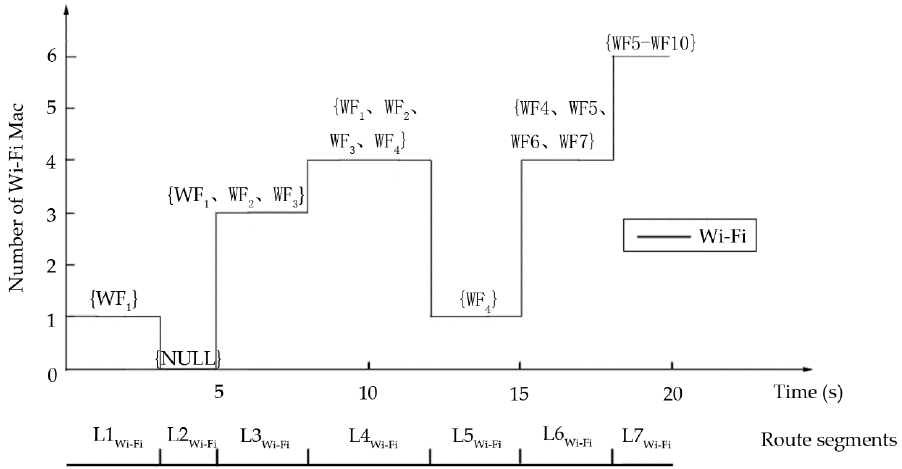
Figure 5. Wi-Fi Media Access Control (MAC) data.